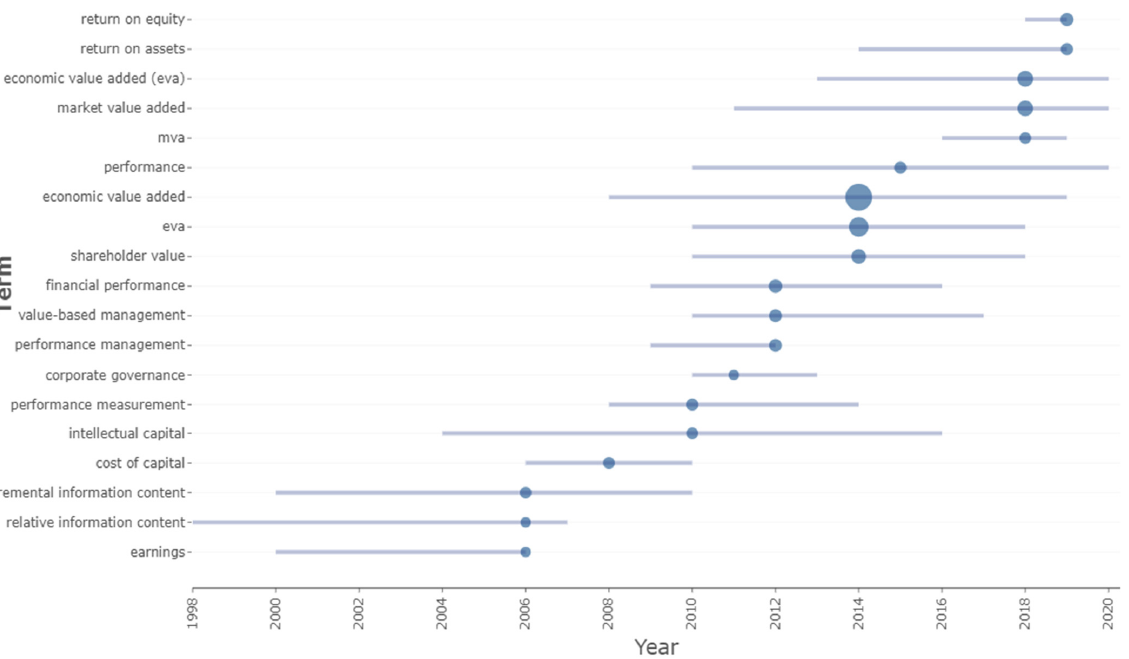
Figure 11. Word map of author’s keywords in EVA research (Biblioshiny). 7. Analysis of Knowledge Clusters in the EVA Research Domain To further deep dive into these clusters and keywords to find sub-themes among the broader clusters, a thematic map was constructed in Biblioshiny (see Figure 5). To analyze the keywords based on the clustering algorithm “walktrap” (Brusco 2022), the “Thematic